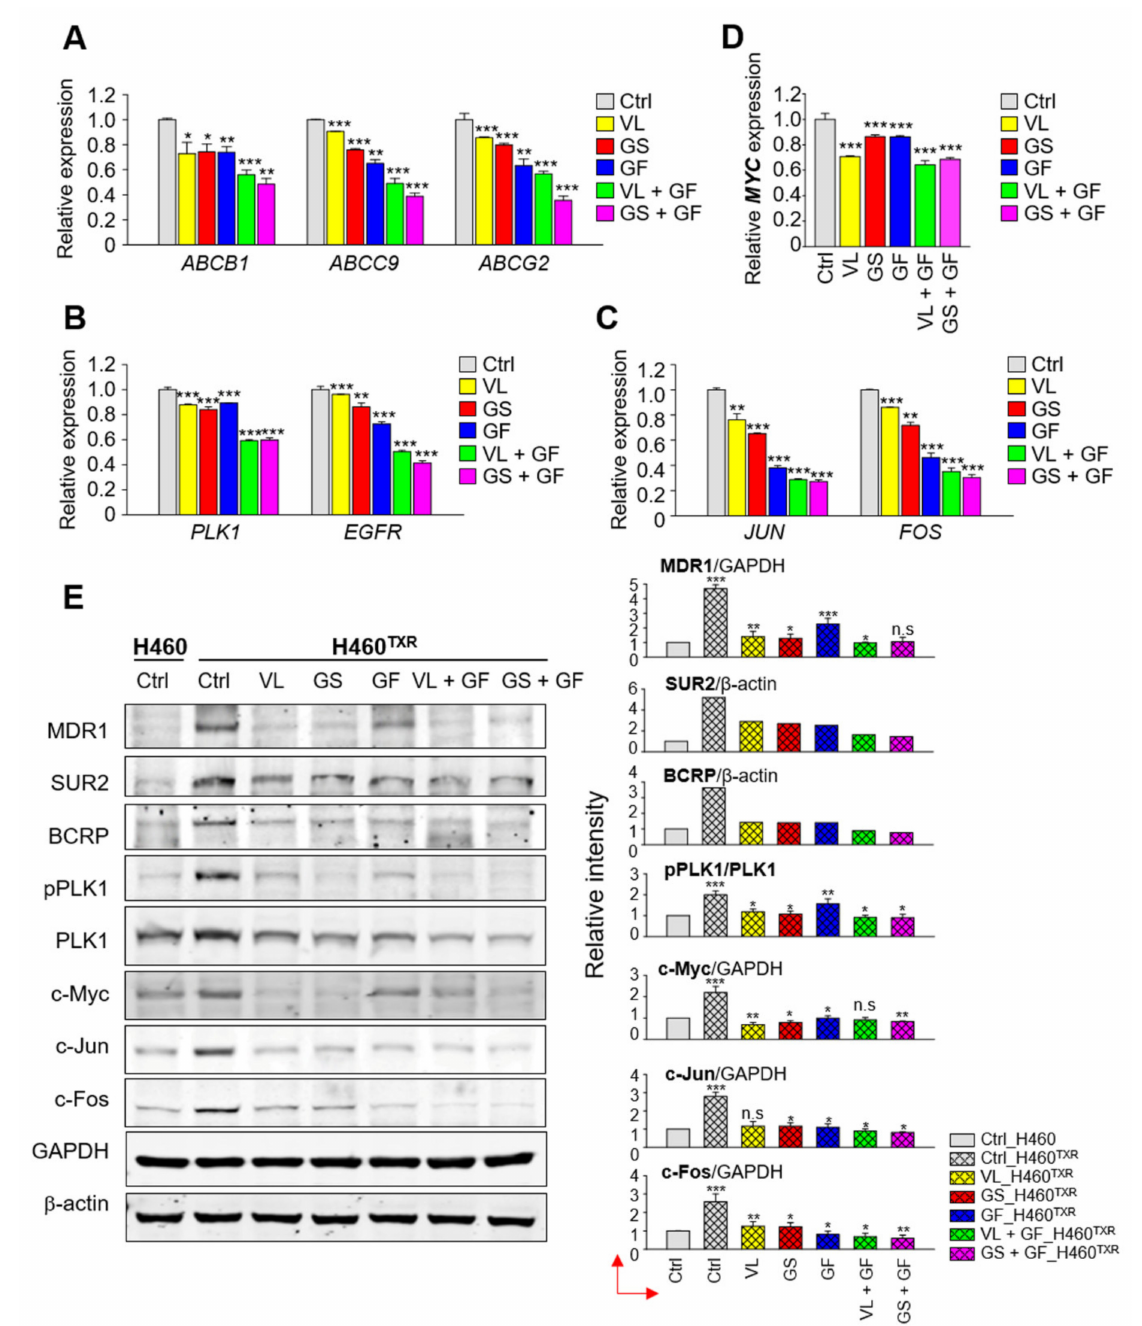
Figure 7. A combination of gefitinib and PLK1 inhibitors effectively reduced the expression of ABC transporters by suppressing EGFR , PLK1 , and MYC in paclitaxel-resistant NCI-H460 TXR cells. Paclitaxel-resistant NCI-H460 (H460 TXR ) cells were grown for 48 h in the presence of 51.4 nM volasertib, 37.8 µ M genistein, or 12.1 µ M gefitinib at the concentration of GI 50 for the single treatments. For the combination treatment at the concentration of GI 50 in TXR cells, 8.1 nM volasertib or 6.9 µ M genistein was co-administered with 1.5 µ M gefitinib (GI 20 ). Quantitative RT-PCR was performed to evaluate the mRNA levels of ( A ) ABCB1, ABCC9, and ABCG2 , ( B ) PLK1 and EGFR , ( C ) JUN and FOS , and ( D ) MYC . The relative expression levels of mRNA were plotted. Three independent experiments were performed. *, p < 0.05; **, p < 0.01; ***, p < 0.001. ( E ) Cell lysates were subjected to immunoblotting with anti-MDR1, anti-SUR2, anti-BCRP, anti-PLK1, anti-p-PLK1, anti-c-Myc, anti-c-Jun, anti-c-Fos, anti-GAPDH, and anti- β -actin antibodies. The relative intensities were quantified using LI-COR Odyssey software (Li-COR Biosciences), normalized, and plotted. *, p < 0.05; **, p < 0.01; ***, p < 0.001 compared with control of